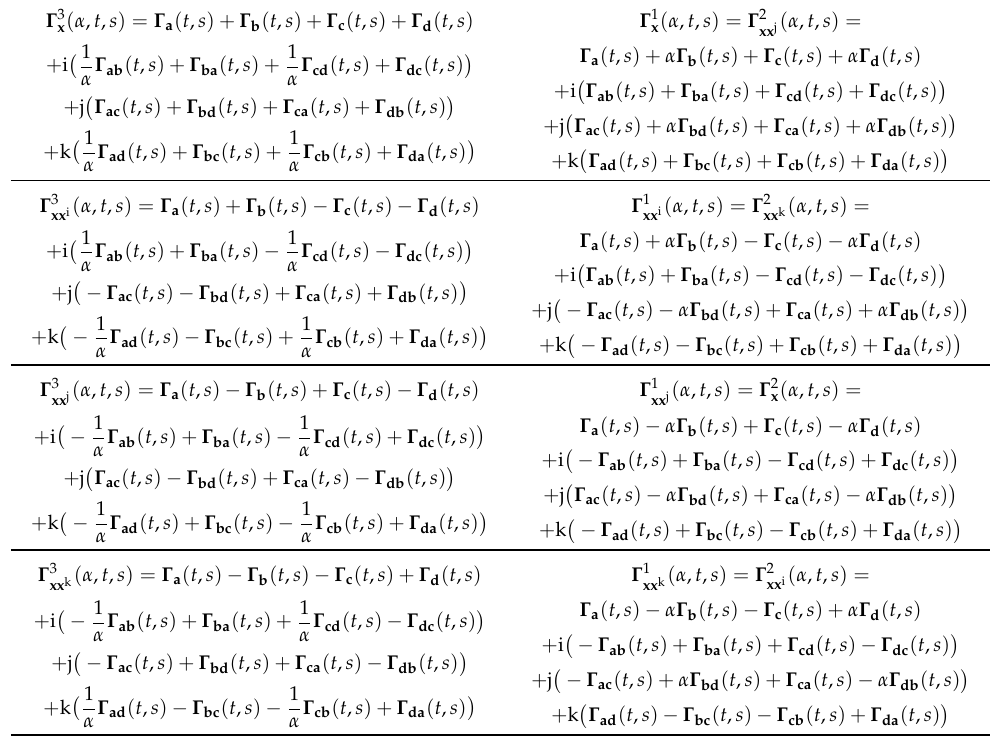
( α , t , s ) , ν = 1,2,3, in function of the correlation functions xx k